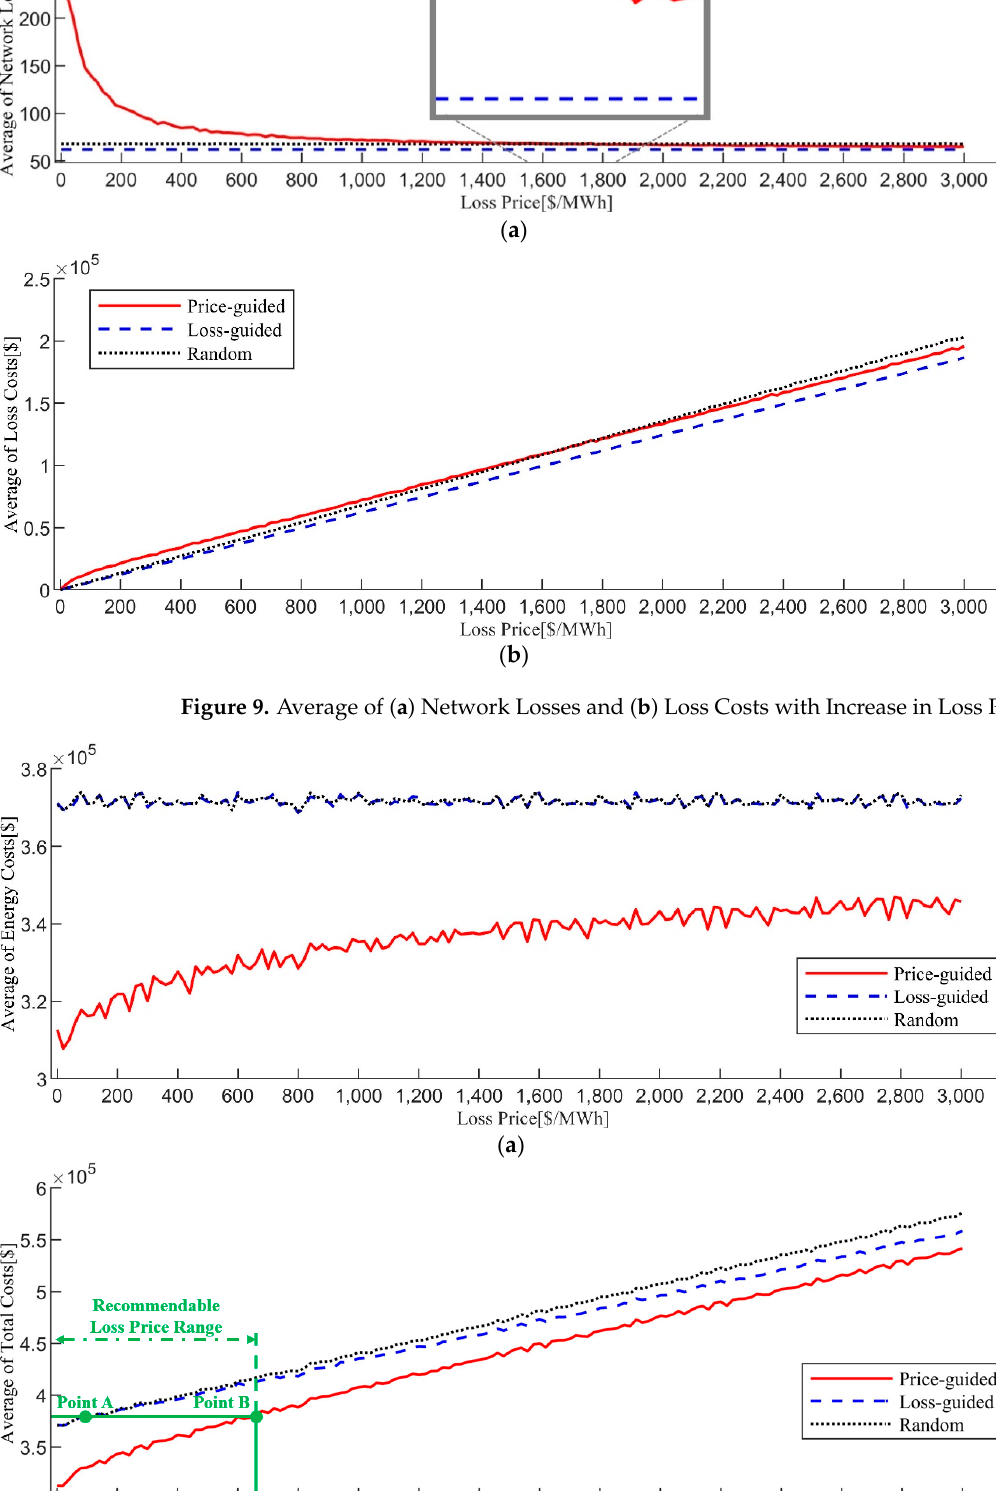
( b ) Random Transaction Case and Price-guided Case.